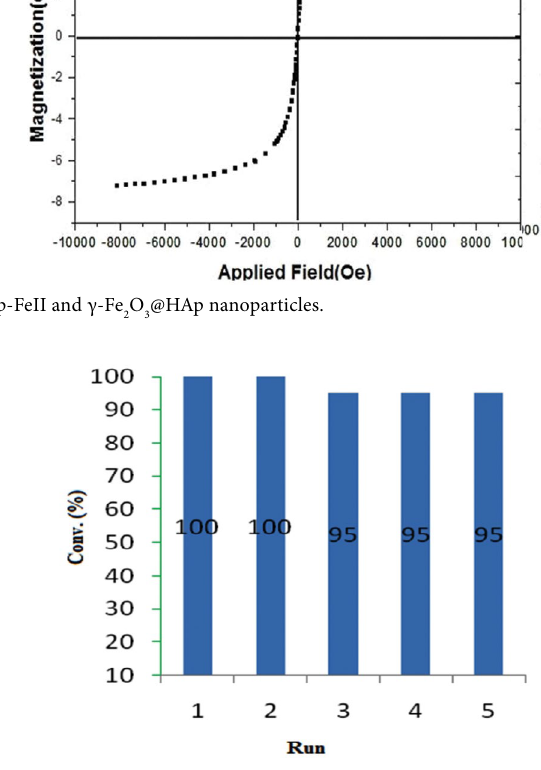
O Fig. 5. Recycling of γ- Fe @HAp-FeII in amination of 2,3-ep- 2 3 oxypropyl phenyl ether (1a) with aniline